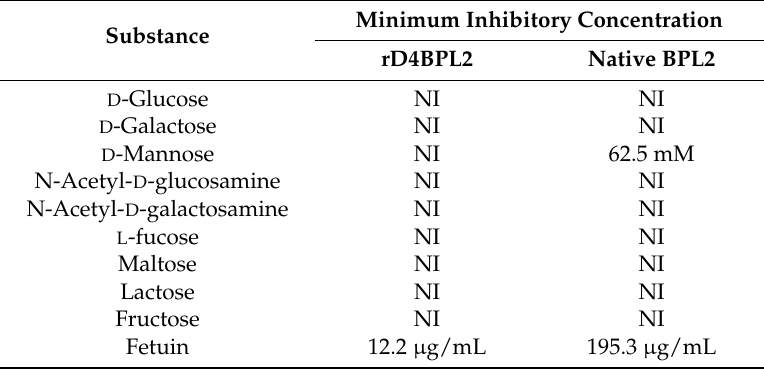
Table 2. Minimum concentrations of various substances for lectin inhibition.